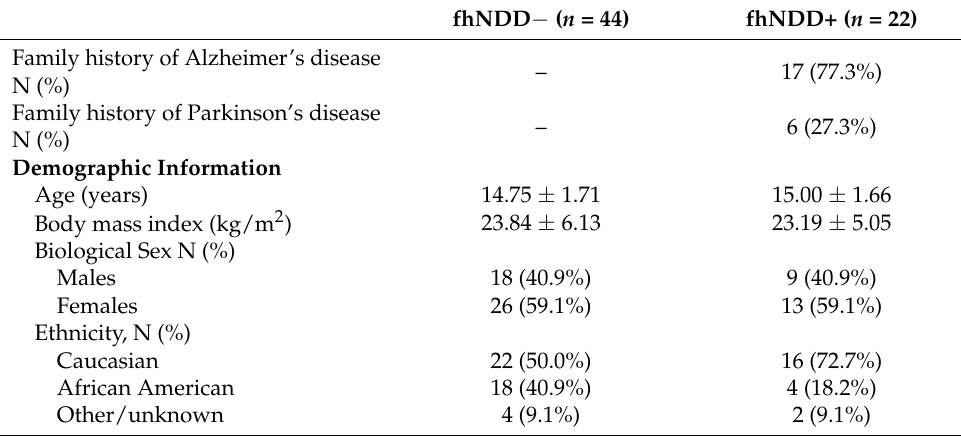
Table 1. Participant demographic information and injury